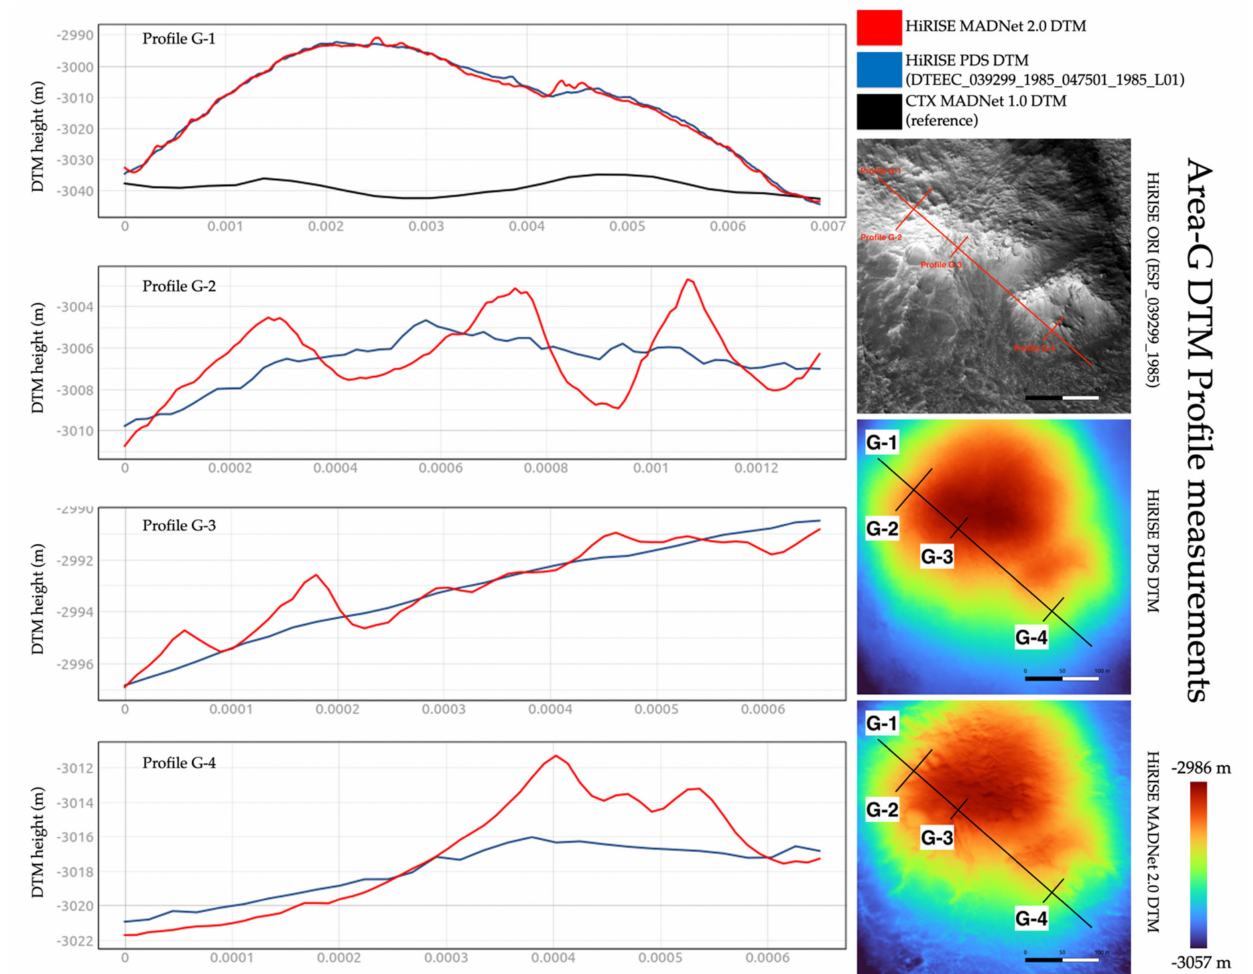
Figure 22. DTM profile measurements of the 1 m/pixel PDS HiRISE DTM, the 25 cm/pixel MADNet 2.0 DTM, and the 12 m/pixel MADNet 1.0 CTX DTMs (the reference DTM) for area-G (location is shown in Figure 10). N.B. all profile measurements begin from the labelled side of the profiles lines that are shown on the image and DTMs to the other end of the